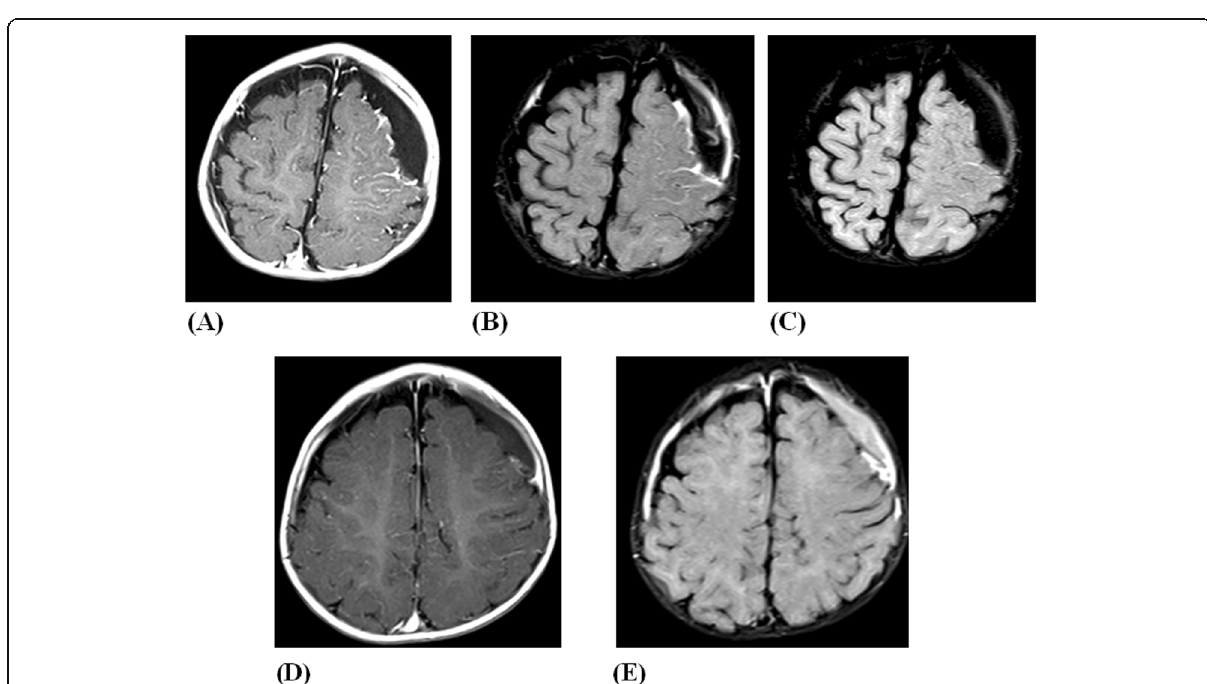
Fig. 1 Axial contrast-enhanced MRI T1WI ( a ) showing small high left frontal subdural fluid collection with related meningeal enhancement. Similar findings but more obvious are seen in axial contrast-enhanced FLAIR ( b ). The non-contrast FLAIR ( c ) shows the difference between pre-contrast study and post-contrast enhancement. On follow-up, contrast-enhanced T1WI ( d ) shows minimal meningeal enhancement which appears more obvious on contrast-enhanced FLAIR image ( e )